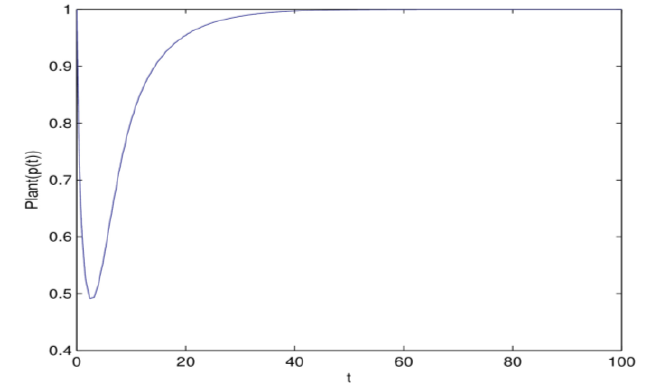
Figure 2. Plant population (𝑃(𝑡)) existing